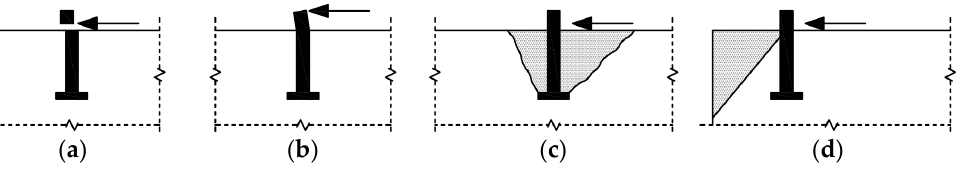
Figure 3. Failure modes under shear loading: ( a ) steel failure without lever arm; ( b ) steel failure with lever arm; ( c ) substrate pry-out failure; and ( d ) edge failure. Adapted from [17].